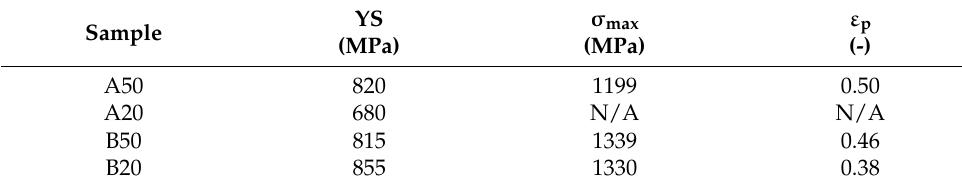
Figure 9. The measured flow stress curves of investigated alloys. Table 3. Results of uniaxial compression tests of investigated